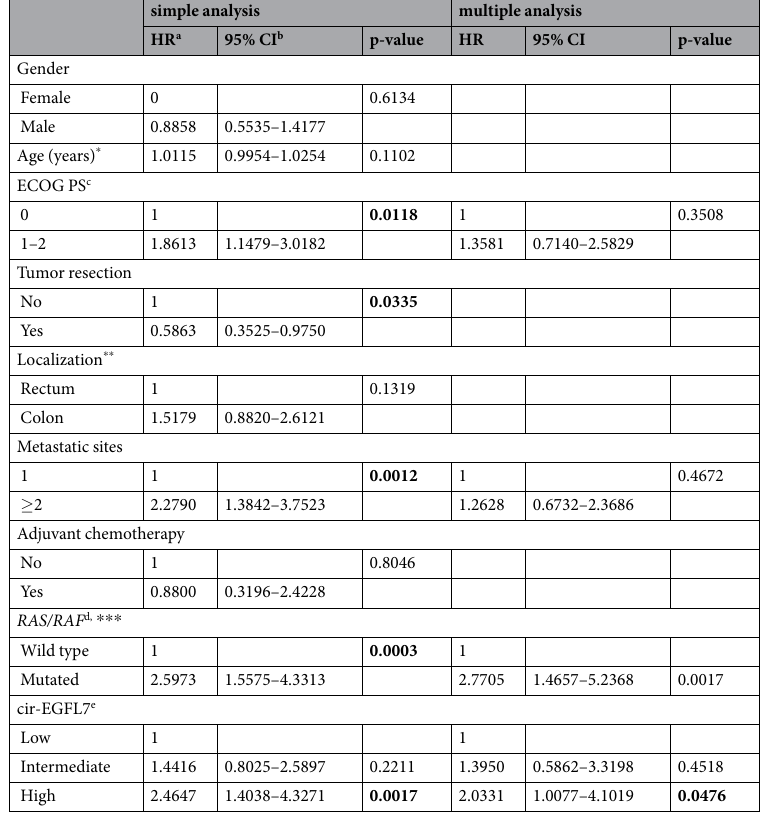
Table 3. Cox regression analysis, overall survival (n = 56 in the multiple analysis). HR a , hazard ratio; CI b , confidence interval; ECOG PS c , Eastern Cooperative Oncology Group Performance Status; RAS/RAF d , KRAS, NRAS, and BRAF mutational status; cir-EGFL7 e , circulating epidermal growth factor-like domain 7. * Age is included in the analysis as a continuous parameter. ** The two patients with synchronous tumours were not included in the analysis. *** The four patients with unknown RAS/RAF mutational status were not included in the Cox regression analysis. The multiple analyses are restricted to patients without prior resection of the primary tumor, due to interaction between tumor resection and cir-EGFL7, leading to N = 54 in the multiple